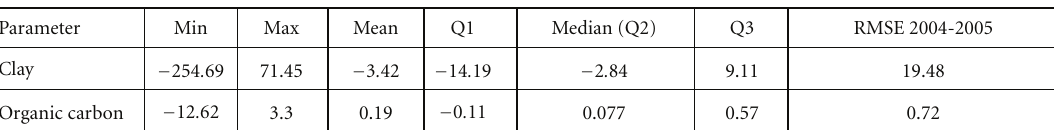
Figure 14: Di ff erence image of estimated clay and organic carbon content based on HyMap images from 2004 and 2005 for an agricultural field near the city of Marienfelde. Q1: lower quartile, Q3: upper quartile. Mean deviation (RMSE) calculated from estimations in 2005 and 2004. The location of this field on the test site DEMMIN is marked by a red flag in Figure 1.